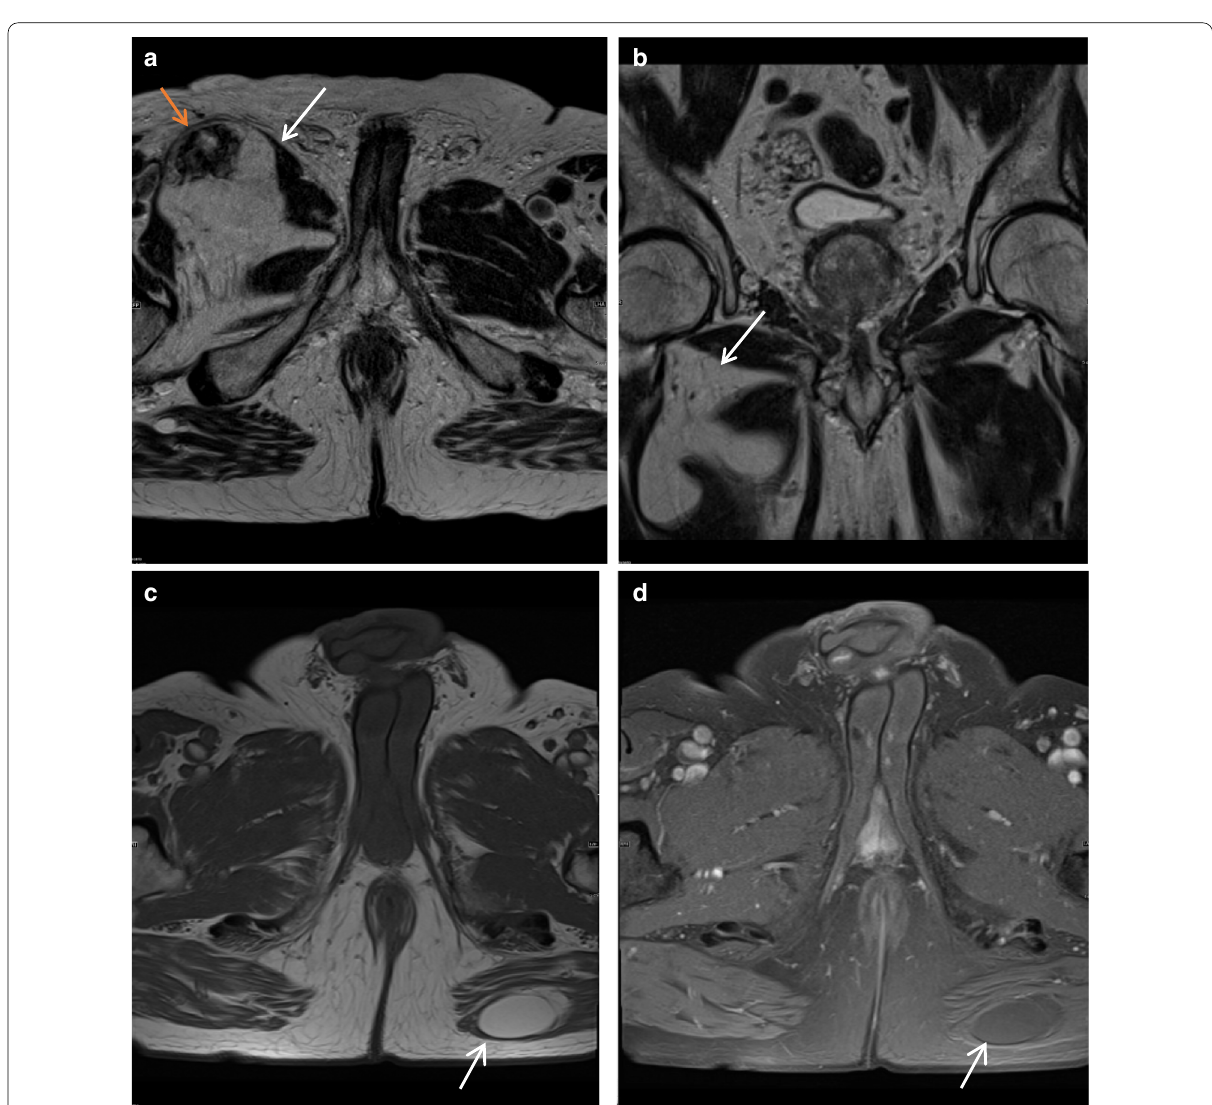
Fig. 13 Lipoma a Axial and b coronal T2W images demonstrate a lipomatous mass within the right adductor compartment (white arrows) which is high T2 signal with a heterogeneous solid component at the anterior aspect (red arrow) which on biopsy represented a region of fat necrosis. c Axial T1 and ( d ) axial T1 fat sat post-contrast sequences show an ovoid lesion in the left gluteus maximus which is high T1 signal and suppresses on the fat sat sequence in keeping with a